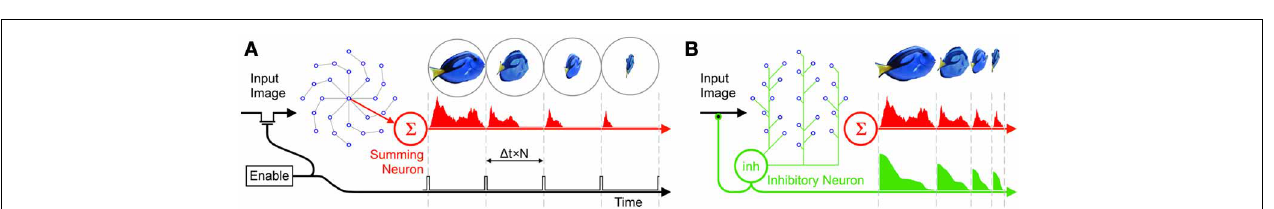
the next frame to be projected. As the target object moves away and the incident image becomes smaller it takes less time for the activation to clear the disc disabling the inhibitory neuron sooner and projecting the frame. In this way the RPN frame rate varies dynamically to maximize TP generation. Note that in the RPN disc shown, (cid:2) = 8 (arms) and N = 4 (neurons per